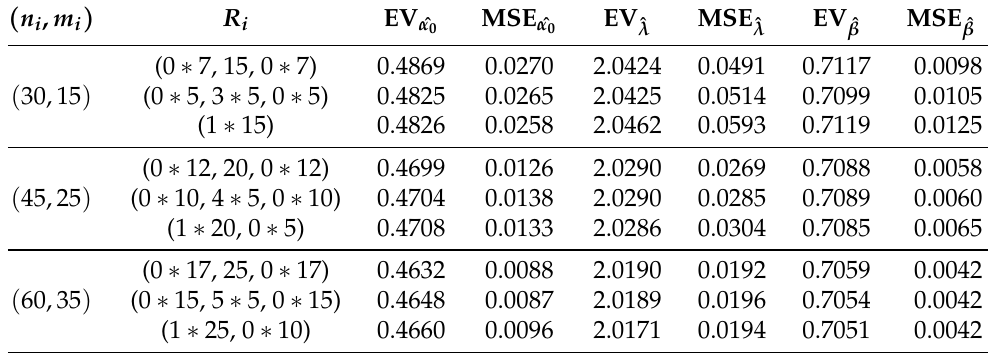
Table 3. The expected values (EV) and mean square errors (MSE) of the Bayes estimates using the Lindley’s approximation for different sample sizes ( n i , m i ) and different censoring schemes R i .